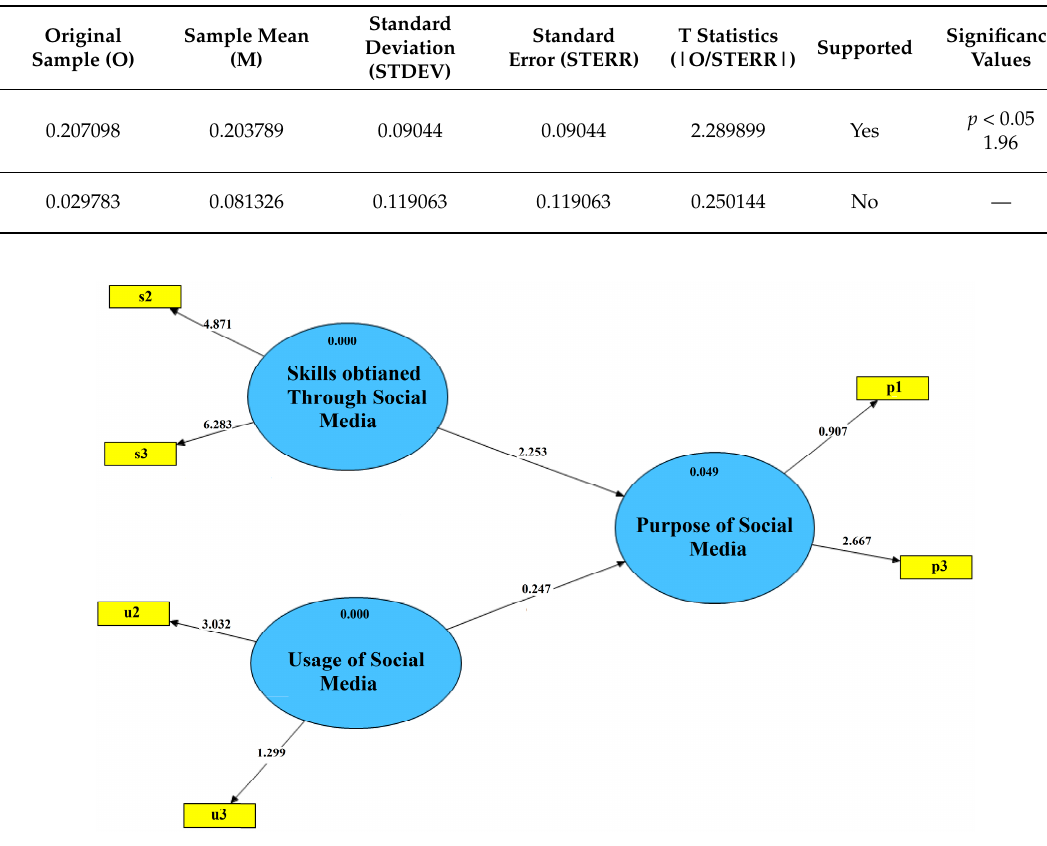
Table 5. Discriminant validity results.